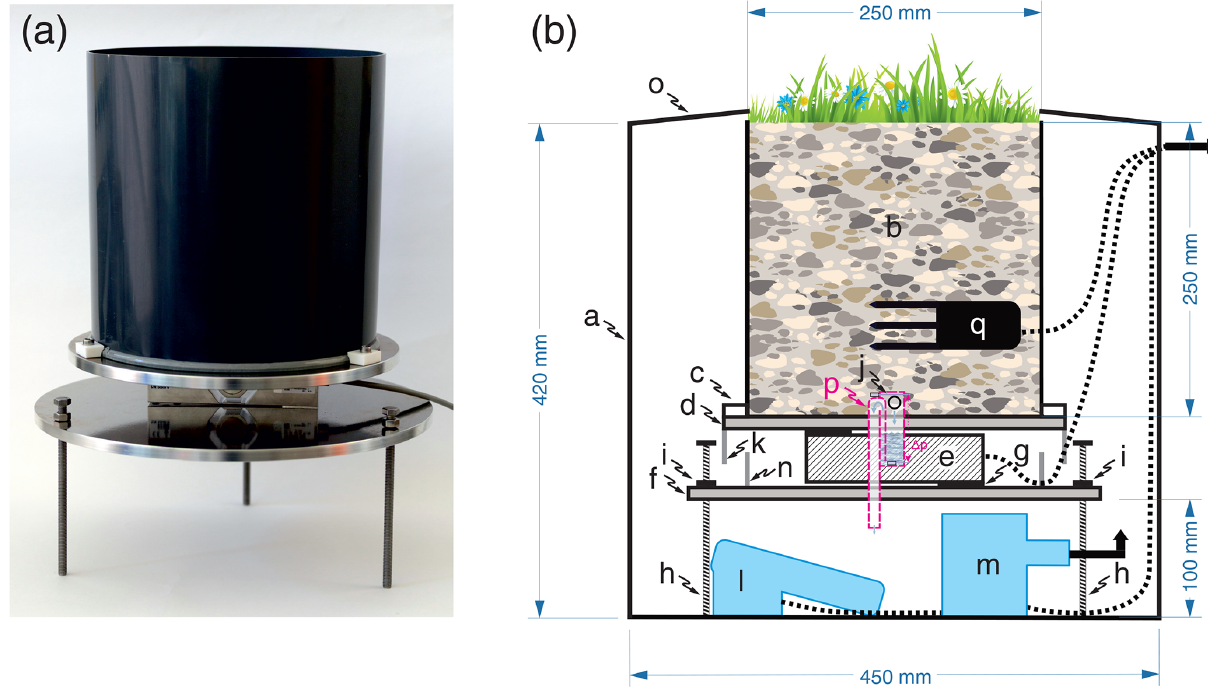
Figure 1. Inner part of the ML (a) and schematic drawing of ML design (b) with a: outer part, b: ML pot, c: socket, d: load plate, e: load cell, f: base plate, g: spacing washer, h: adjustable support feet, i: counter nut for adjustable support feet, j: drainage-water outlet, k: water guide, l: float switch, m: bilge pump, n: water and dirt protection, o: cover lid, p: optional sensor or drop counter to quantify drainage for applications that do not specifically target drought conditions, and q: soil moisture and temperature